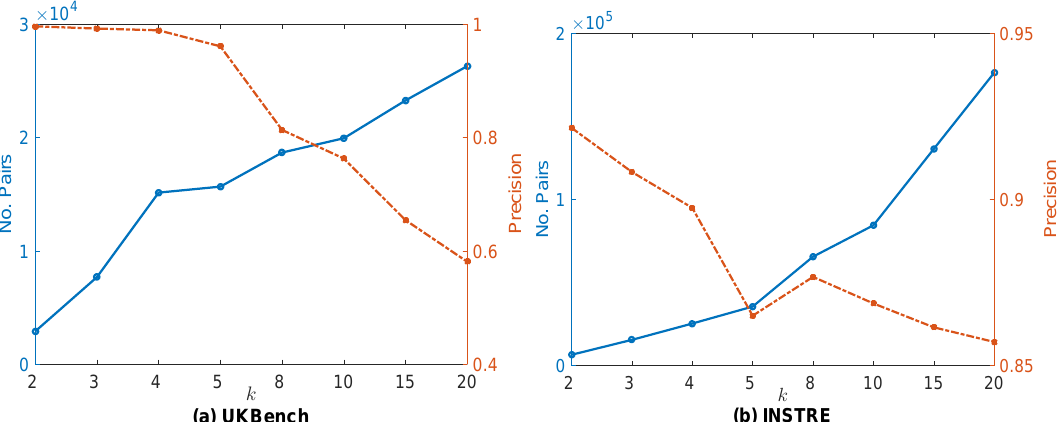
Figure 3. Impact of the number of nearest neighbor k on the number of mined image pairs (no. of pairs) and its corresponding precision. The experiment is conducted on UKBench ( a ) and INSTRE ( b ) with ResNet-50. Only the first mining iteration is recorded. Precision denotes the ratio of true positive pairs over all mined image pairs. Note that anchor image is counted, so k starts from